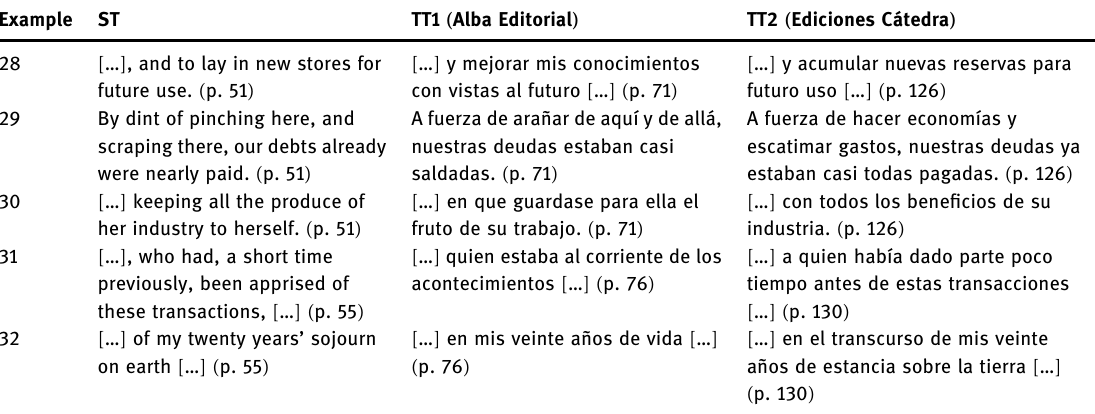
Table 6: Examples taken from Chapter 6 Example ST